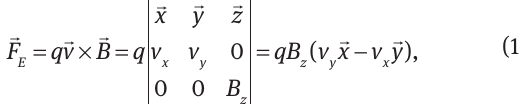
= 4.480 GHz. The red and 1